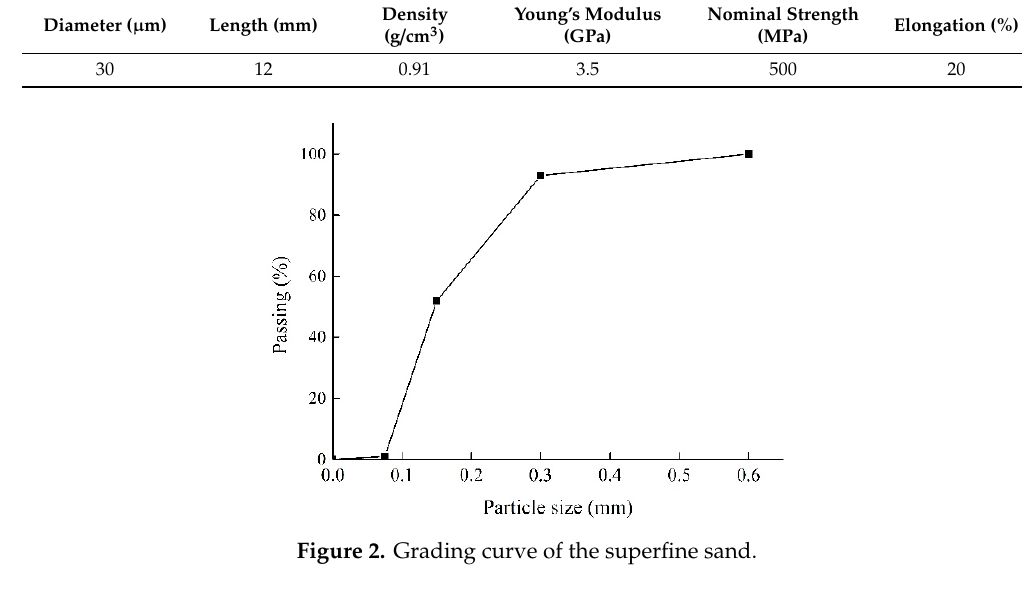
Table 2. Properties of polypropylene (PP) fiber.